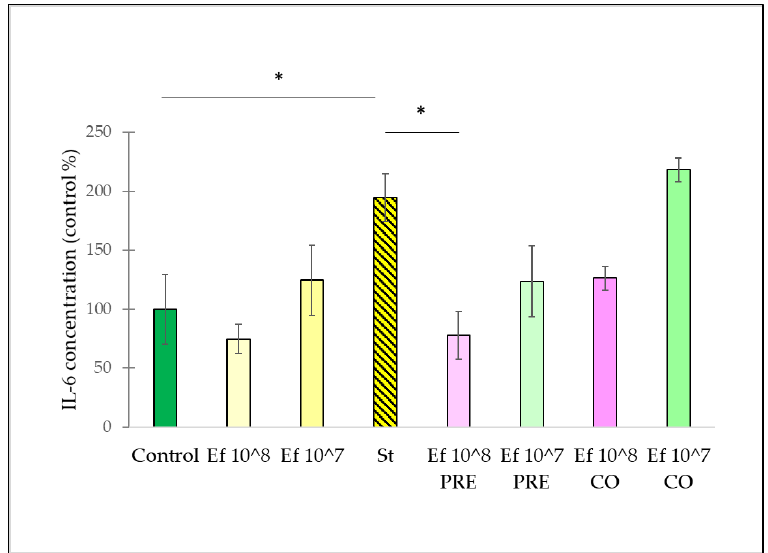
Figure 5. Induction of IL-6 secretion of IPEC-J2 cells after stimulation with S. Typhimurium and E. faecium . E. faecium was added 1 h before (pre-treatment) or at the same time (co-treatment) of the addition of S. Typhimurium. E. faecium was added in 10 8 CFU/mL or in 10 7 CFU/mL concentration. Control : plain cell culture medium treatment; St : S. Typhimurium 10 6 CFU/mL; Ef 10^8 : E. faecium 10 8 CFU/mL; Ef 10^7 : E. faecium 10 7 CFU/mL ; Ef 10^8 PRE : pre-treatment with E. faecium 10 8 CFU/mL + S. Typhimurium 10 6 CFU/mL; Ef 10^7 PRE : pre-treatment with E. faecium 10 7 CFU/mL + S. Typhimurium 10 6 CFU/mL; Ef 10^8 CO : co-treatment with E. faecium 10 8 CFU/mL + S. Typhimurium 10 6 CFU/mL; Ef 10^7 CO : co-treatment with E. faecium 10 7 CFU/mL + S. Typhimurium 10 6 CFU/mL. Data are shown as means with standard deviations, n = 6/group. * p ≤ 0.05 .